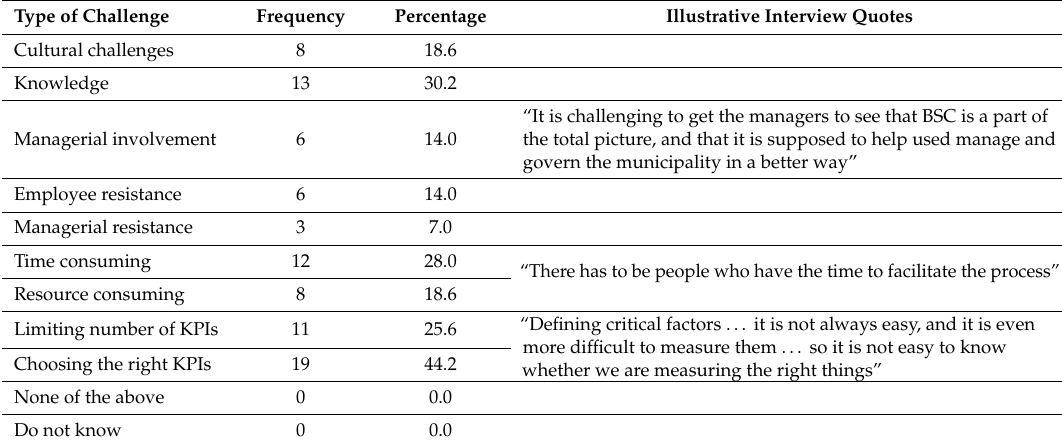
Table 18. Challenges related to BSC implementation (N = 43).